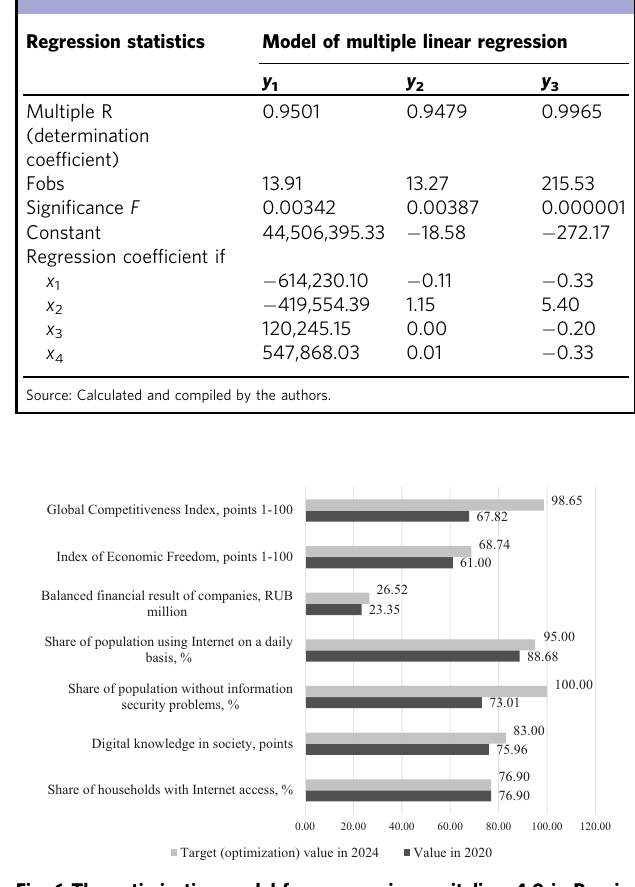
Table 2 Modelling of the regression dependence of Russian ‘ capitalism 4.0 ’ on the indicators for the digital society.